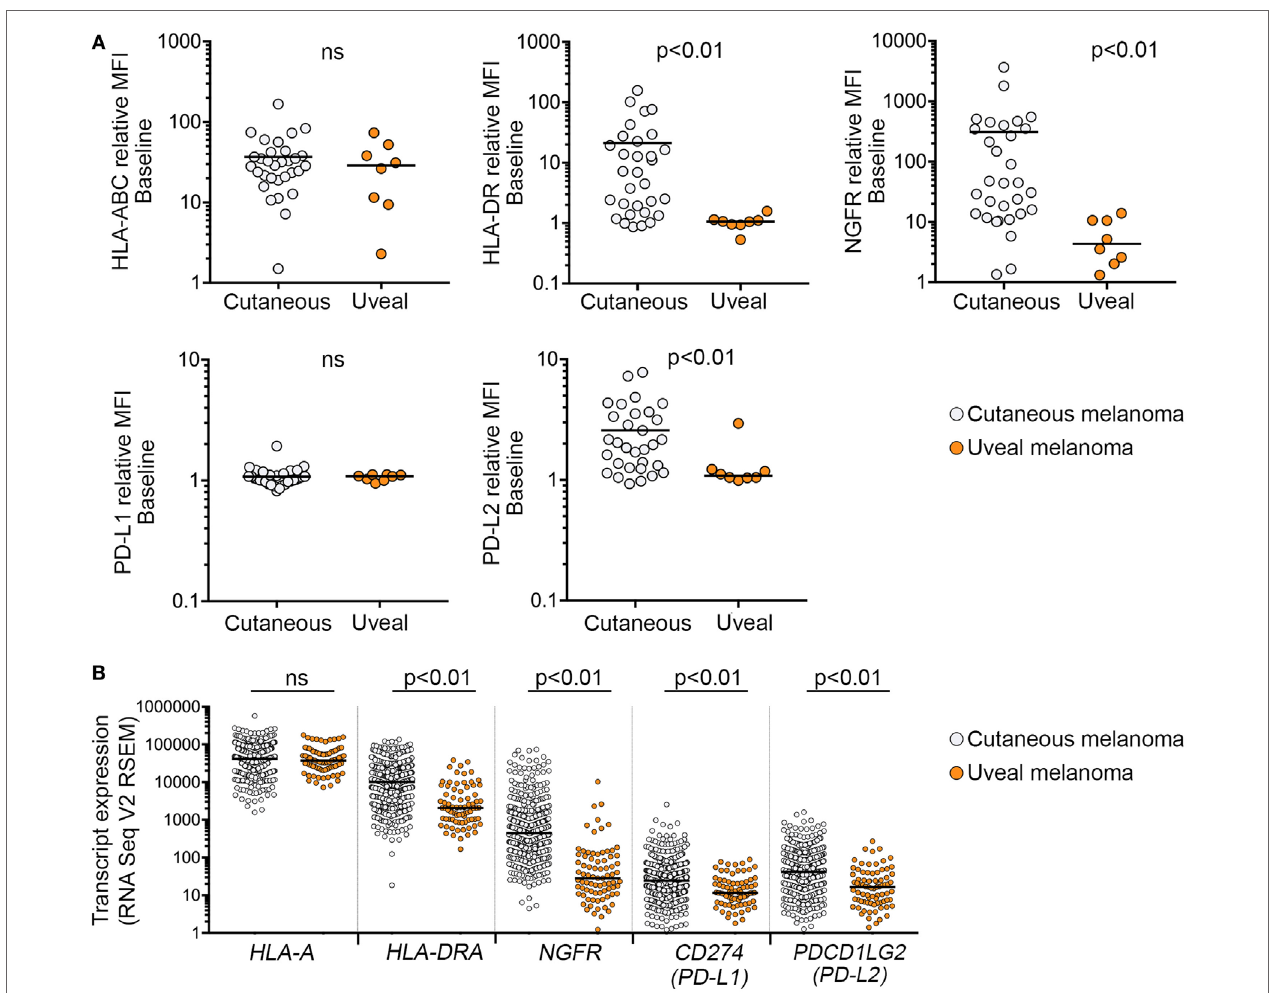
FigUre 2 | Expression of interferon- γ targets in cutaneous and uveal melanoma (UVM) cells. (a) Cell surface expression [relative mean fluorescence intensity (MFI)] of HLA-ABC, HLA-DR, nerve growth factor receptor (NGFR), PD-L1, and PD-L2 in cutaneous ( n = 31) and UVM ( n = 8) cell lines. (B) Expression of mRNA transcripts for HLA-A , HLA-DRA , NGFR , PD-L1 , and PD-L2 in the 80 uveal [The Cancer Genome Atlas (TCGA) UVM dataset] and 472 cutaneous melanoma samples (TCGA skin cutaneous melanoma dataset). Each dot represents a single sample, with the median indicated by the horizontal line. Expression levels were compared using a Mann–Whitney test; ns, not